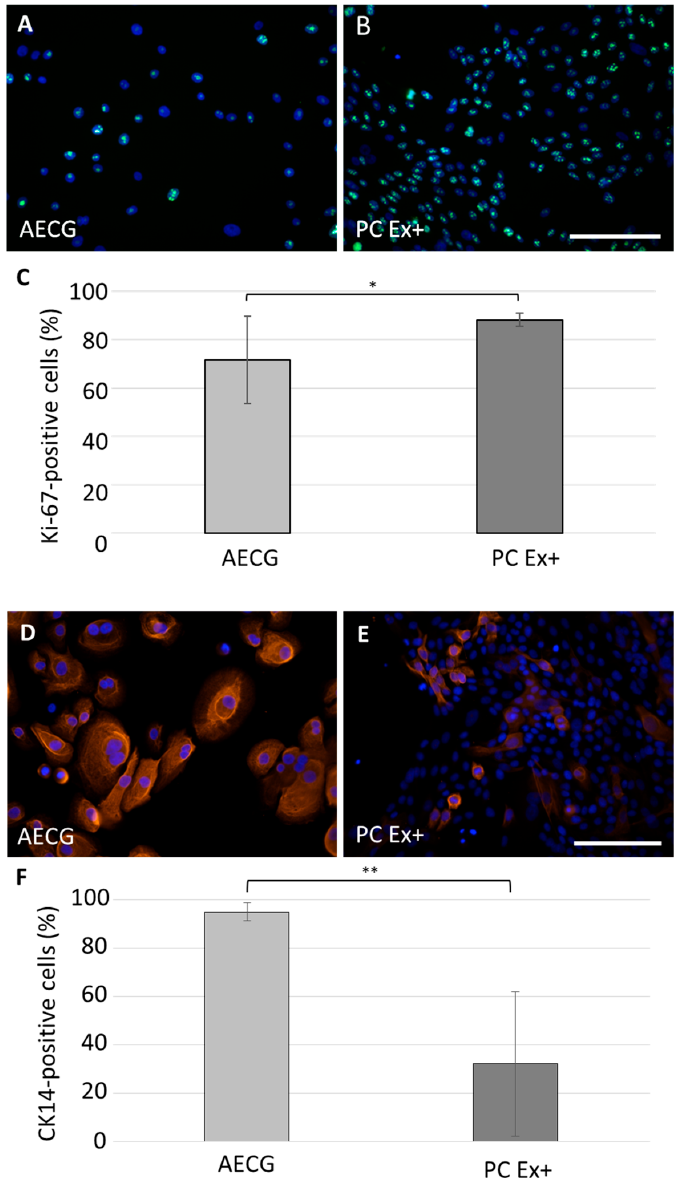
Figure 1. Expansion of primary human bronchial epithelial cells (hbEC). hbEC were expanded either in airway epithelial cell growth (AECG) or PneumaCult ExPlus (PC Ex+) medium and characterized with immunofluorescence staining in passage 1. ( A – C ) Immunofluorescence staining against Ki-67 (green) on hbEC cultivated with ( A ) AECG and ( B ) PC Ex+ medium and ( C ) determination of the percentage of Ki-67-positive cells (AECG (light grey, n = 5 from three donors); PC Ex+ (dark grey, n = 4 from three donors). ( D – F ) Immunofluorescence staining against cytokeratin 14 (CK14, red) on hbEC cultivated with ( D ) AECG or ( E ) PC Ex+ medium and ( F ) evaluation of the percentage of CK14-positive cells (AECG (light grey) and PC Ex+ (dark grey), n = 7 each from five donors). Nuclei were stained with DAPI (blue). Cell culture in AECG medium resulted in increased cell size. Scale bar: 100 µ m. Shown are the mean average with standard deviation. * p < 0.05; ** p <